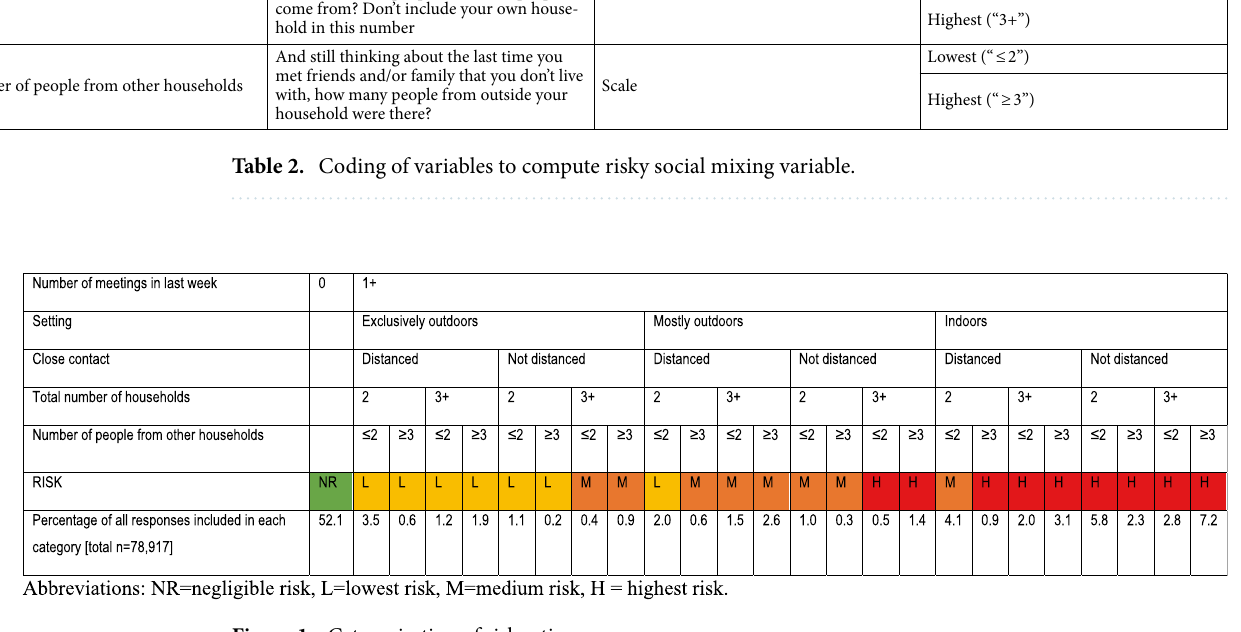
Figure 1. Categorisation of risk